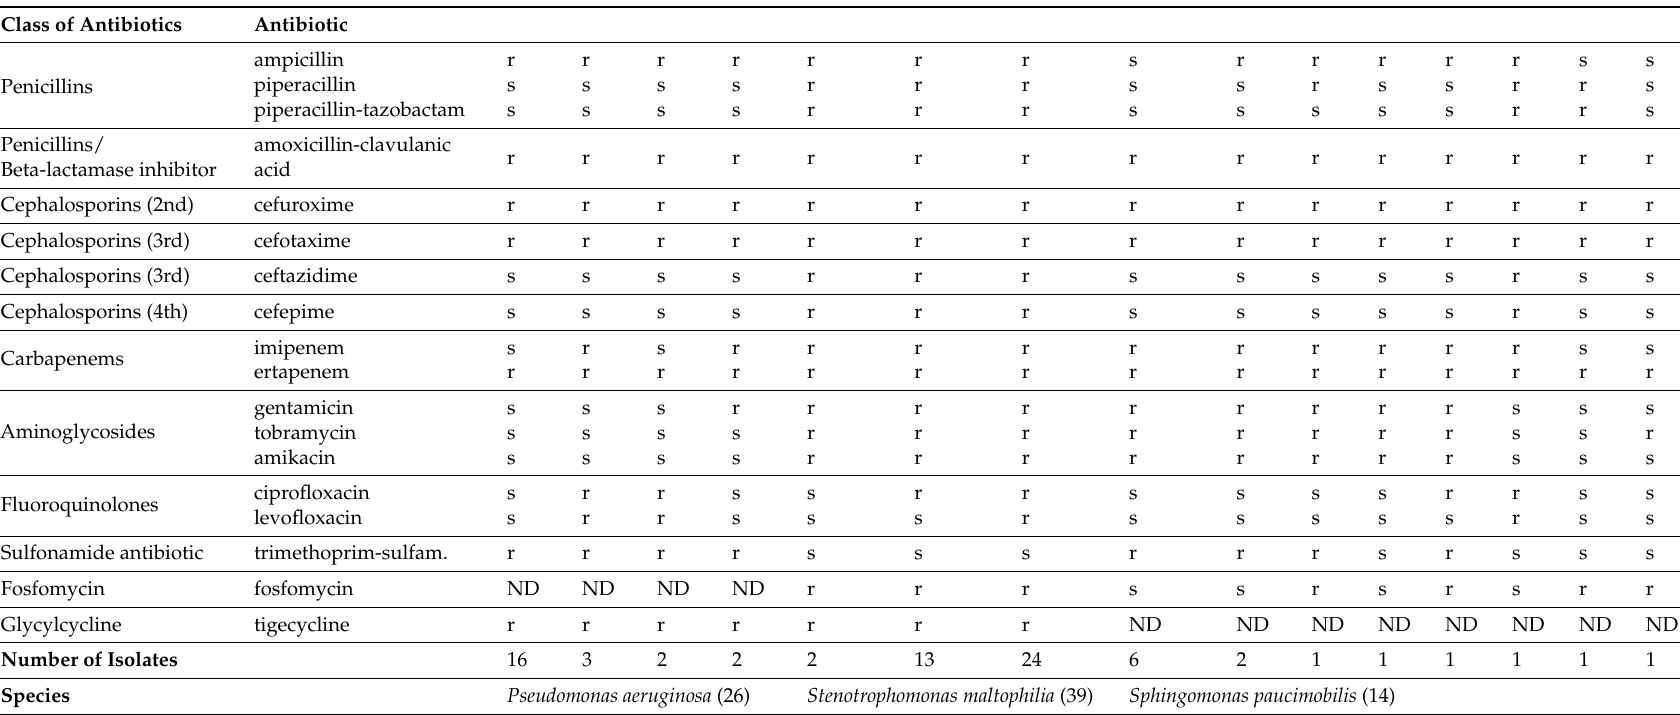
Table 5. Antibiotic resistance patterns of all Pseudomonas aeruginosa , Stenotrophomonas maltophilia , and Sphingomonas paucimobilis isolates from water and surface samples. Class of Antibiotics Antibiotic Penicillins Penicillins/ Beta-lactamase inhibitor